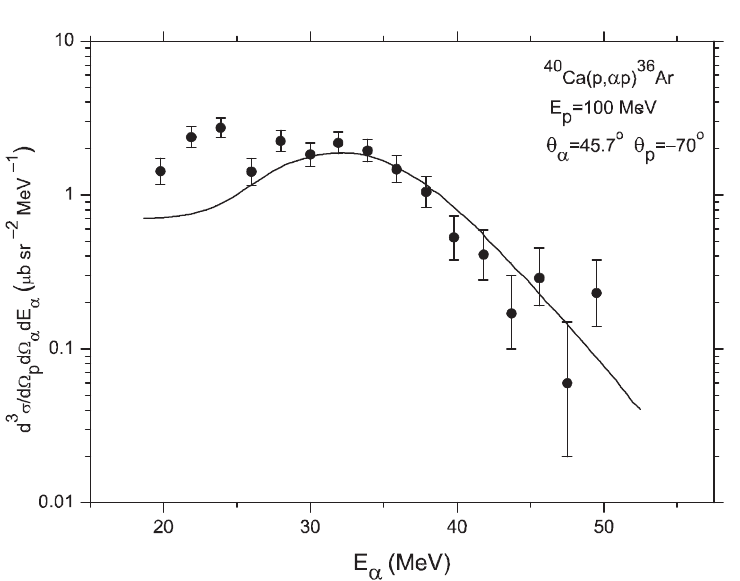
Fig. 4. Results for the 40 Ca(p, αp) 36 Ar knockout reaction extracted from the data of Carey et al. [12] at an incident energy of 100 MeV. See caption to Fig. 2 for further